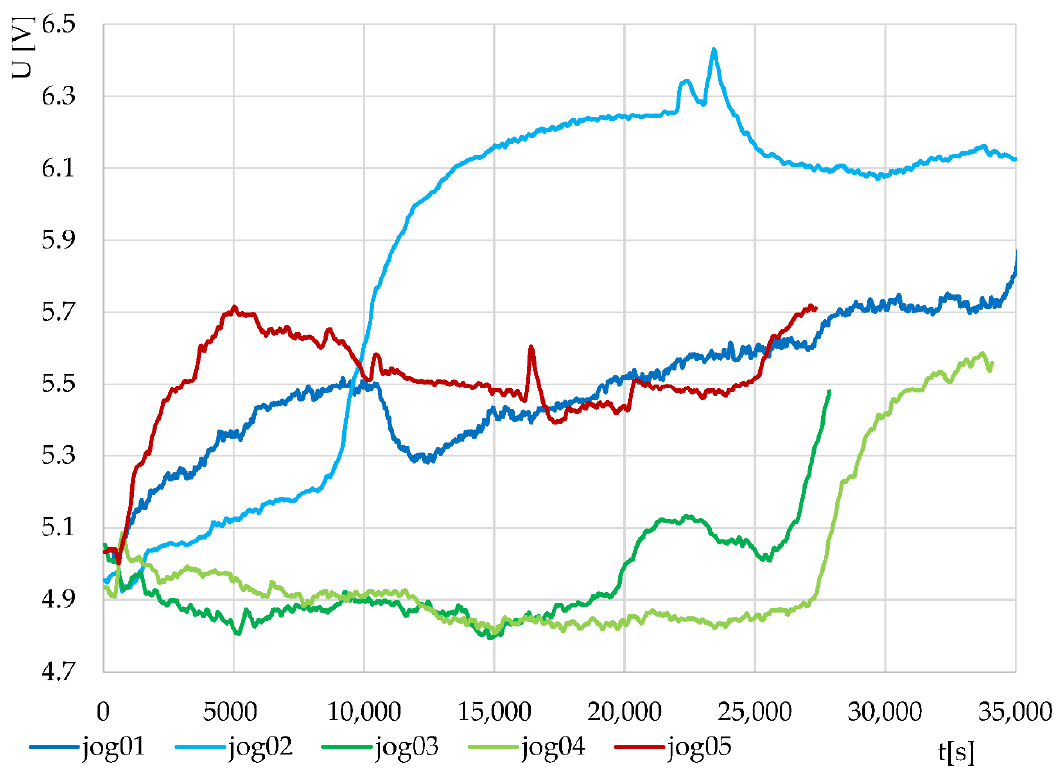
Figure 7. Monitoring of yoghurt fermentation without additives (jog01, jog02), with the addition of edible insect flour (jog03, jog04), and with the addition of goji berry (jog05) for thermodynamic system S1.